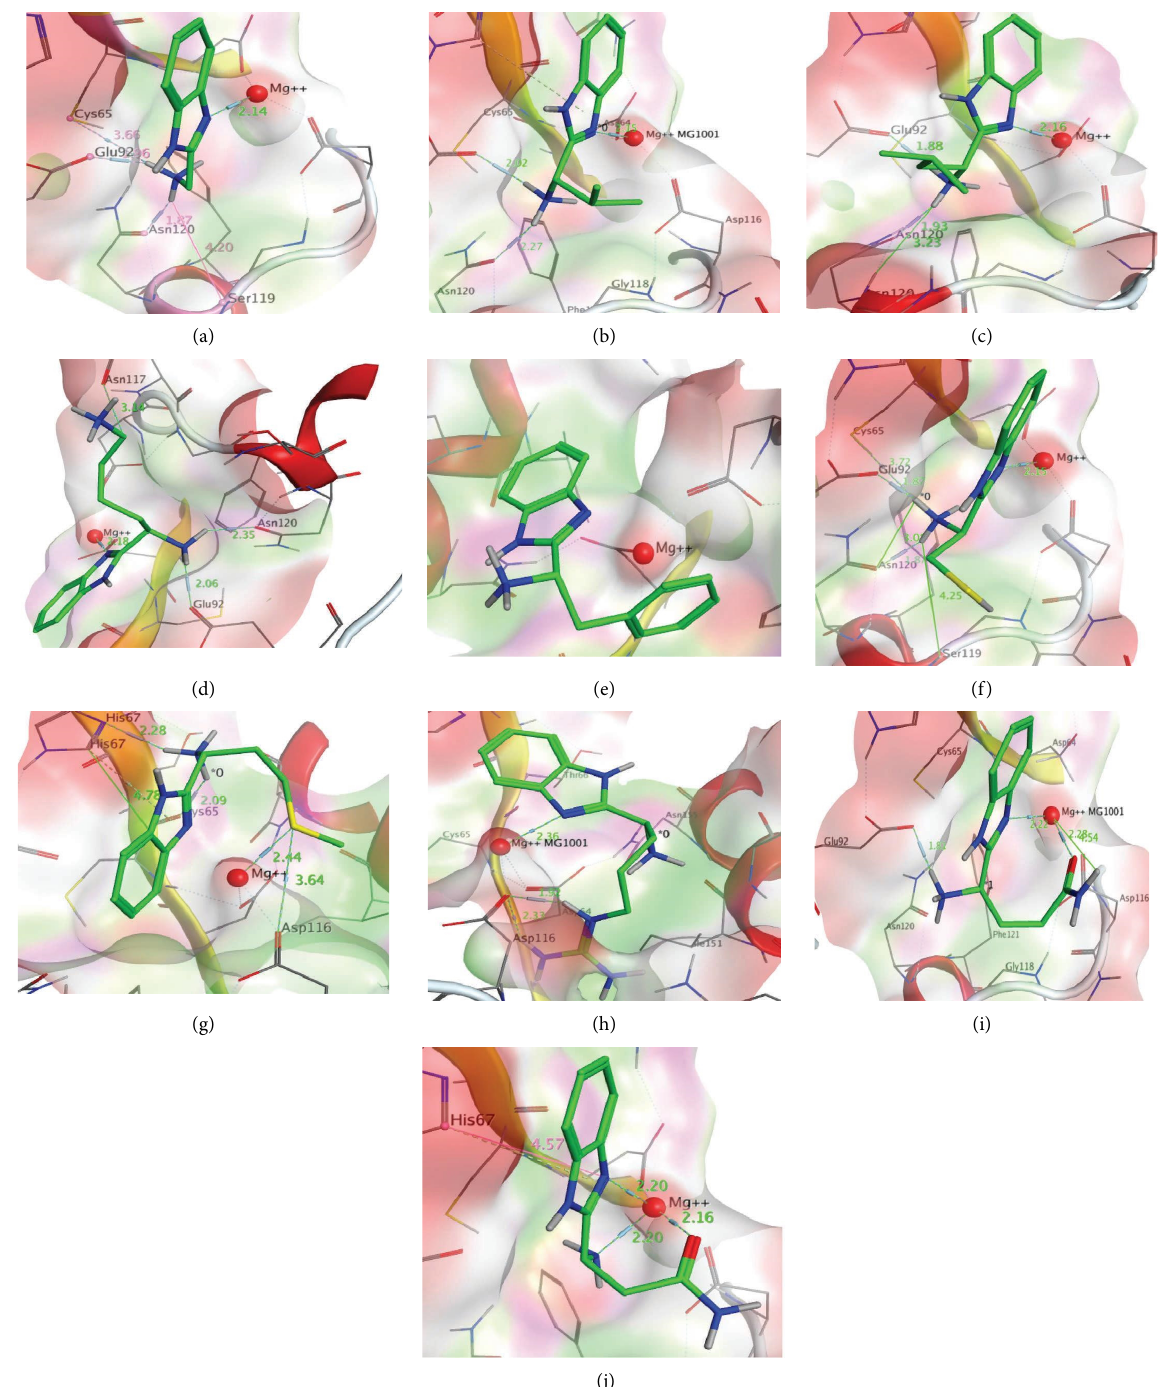
Figure 5: Close-up view of the binding interactions of HIV-1 integrase CCD dimer with compounds (a) Compound (a). (b) Compound (b). (c) Compound (c). (d) Compound (d). (e) Compound (e). (f) Compound (f). (g) Compound (g). (h) Compound (h). (i) Compound (i). (j) Compound (j). Interacting residues of HIV-1 integrase CCD dimer are shown in sticks colored by atom type, carbon is colored green, nitrogen is colored blue, oxygen is colored red, and Mg 2+ is colored